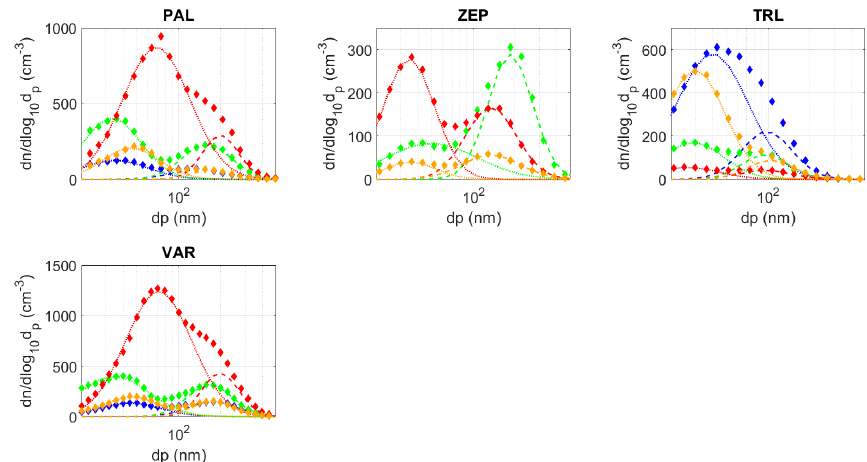
Figure A1. Median particle size distributions (diamonds) and corresponding modes (dotted lines) at polar sites. Blue lines and markers correspond to DJF, green lines and markers to MAM, red lines and markers to JJA, and orange lines and markers to SON.